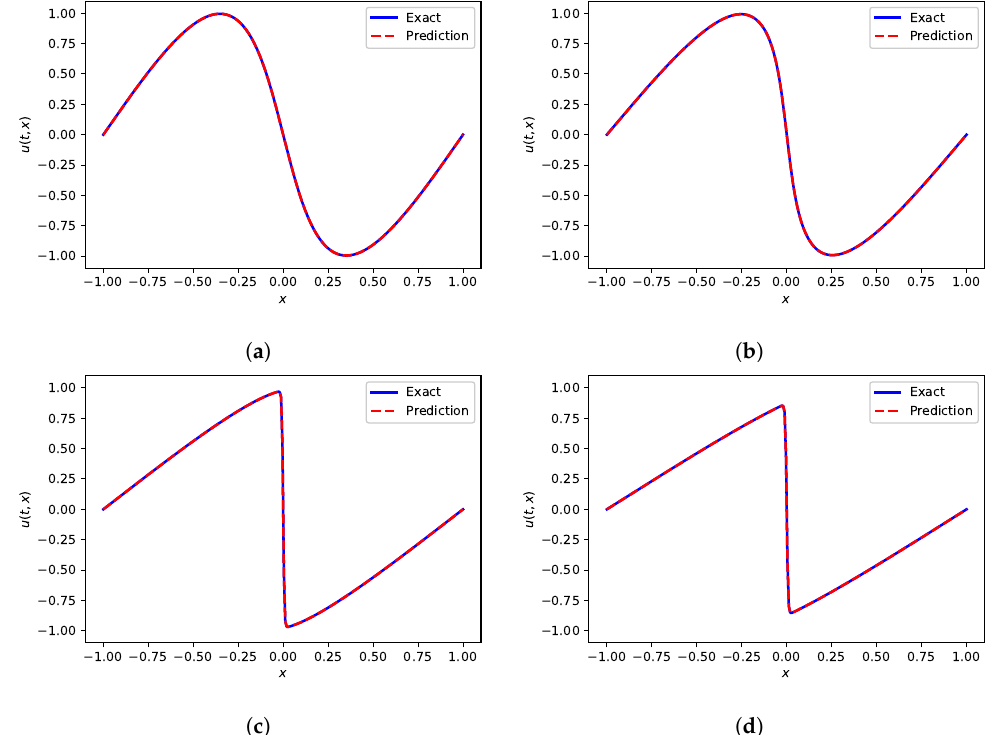
Figure 13. Comparison of predicted solution and exact solution of Equation (39) corresponding to different temporal snapshots. ( a ) t = 0.15; ( b ) t = 0.25; ( c ) t = 0.55; ( d ) t =